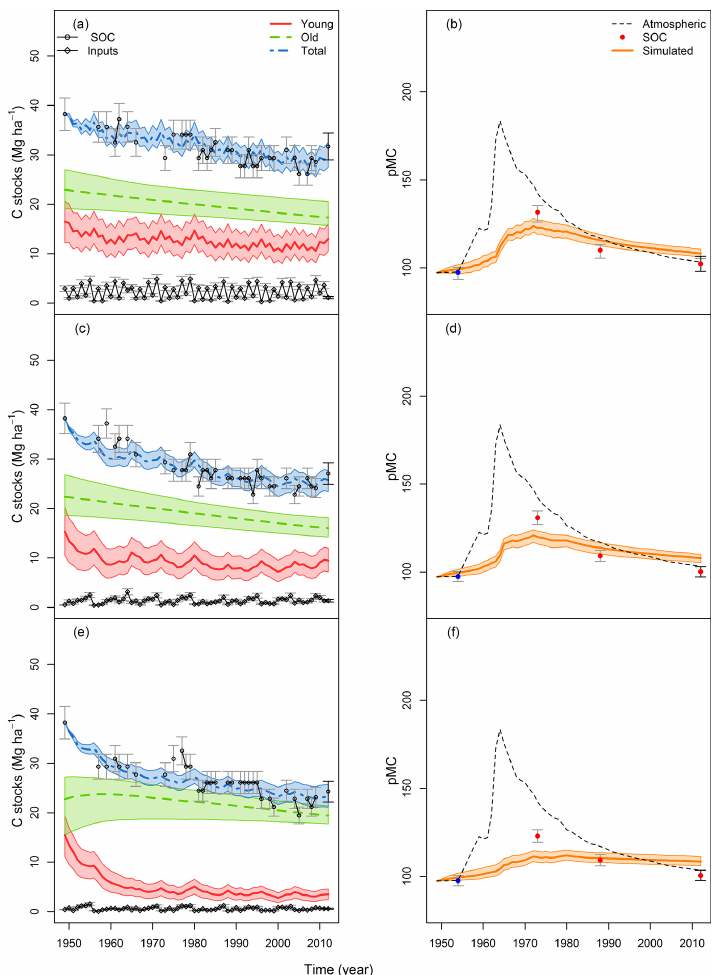
Figure 7. Simulation of SOC pools (a, c, e) and 14 C pools (b, d, f) in the ZOFE trial as described by model structure I, with weighting factor = 0.35, together with the measured data. Error bars represent the measured (black) and estimated (dark grey) standard error of the measurements. SOC (a, c, e) is in Mgha − 1 , while SO 14 C (b, d, f) is in